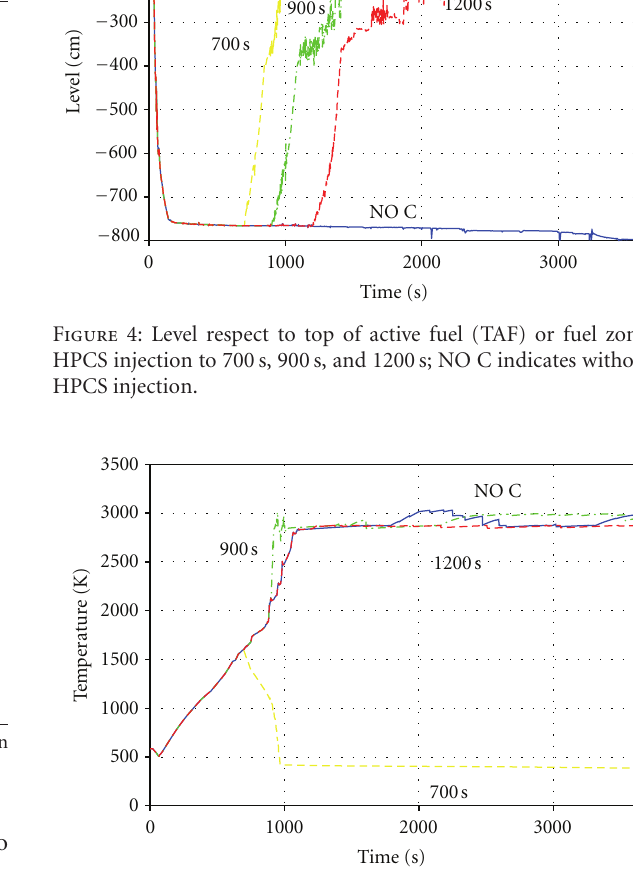
Figure 5: Maximum surface temperature in the core. HPCS injection to 700s, 900s, and 1200s; NO C indicates without HPCS